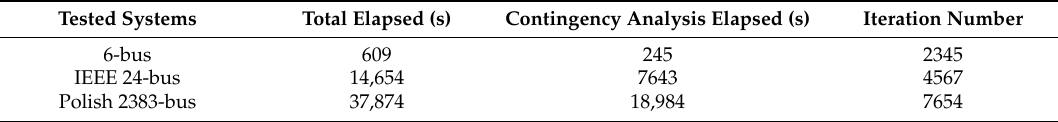
Table 8. Computational performances on different tested